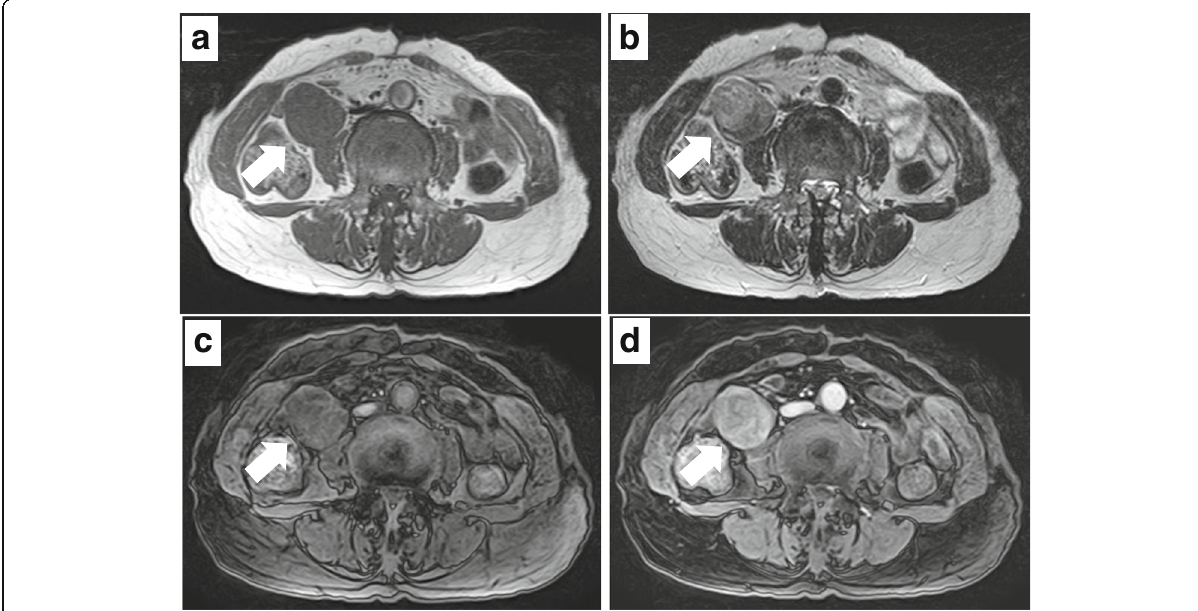
Fig. 2 Magnetic resonance imaging of the leiomyosarcoma. a Axial T1-weighted magnetic resonance imaging (MRI) of the abdomen revealing a tumor (white arrows) with diffuse low intensity. b Axial T2-weighted MRI revealing a tumor with uniform low intensity. Early-phase ( c) and late- phase ( d ) axial gadolinium-enhanced MRI revealing heterogeneous and incremental enhancement of the